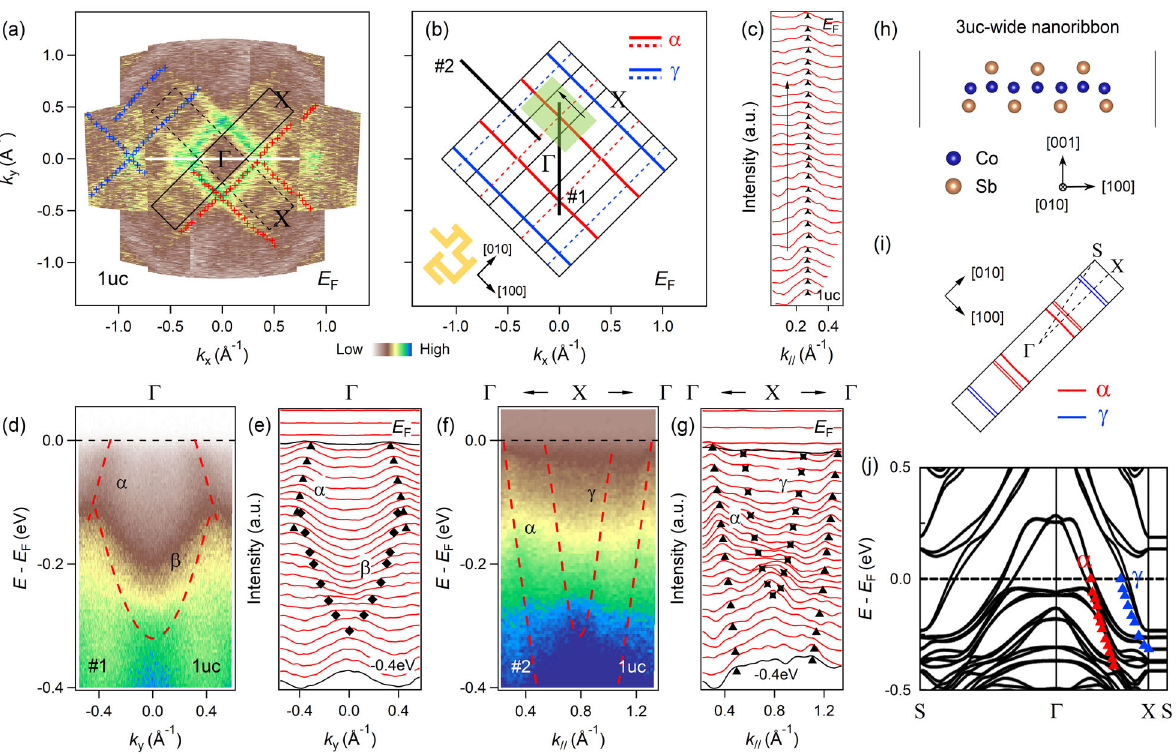
Fig. 2 FS topology and band structures of CoSb 1 − x nanoribbons. a Constant-energy ARPES image of Sample III (1 uc) was obtained by integrating the photoemission intensity within E F ± 40 meV. The red and blue cross marks are measured Fermi crossings. b Schematic FS topology of ( a ). Inset: Sketches of the [100] and [010] oriented CoSb 1 − x nanoribbons. The black solid and dashed lines in ( a ) represent the Q1D BZs of [010] and [100] oriented nanoribbons, respectively. The black solid lines in (b) indicate a series of Q1D BZs of [010] oriented nanoribbons, while the BZs of [100] orientation are omitted for better visualization. The solid and dashed schematic FS lines in ( b ) represent that of [010] and [100] oriented nanoribbons, respectively. c MDC plot of the constant-energy spectra in ( a ), which is indicated by the translucent green area in ( b ). The triangle markers are extracted from peak positions. d , e Intensity plot and corresponding MDCs along cut#1 in ( b ), respectively. f , g Same as ( d , e ) along cut#2 in ( b ). The red dashed curves in ( d , f ) are guides to the eye for the experimental band dispersions. The black markers in ( e , g ) are extracted peak positions. h Supercell contains an [010]-oriented ribbon of the freestanding tetragonal CoSb with a width of 3 uc (~1.2 nm). i Calculated FSs of the CoSb supercell in ( h ). The BZ of the supercell represented by the black solid lines shows an aspect ratio of 5: 1. j Calculated band structures of 3-uc-wide CoSb nanoribbon. The red and blue markers are experimental α and γ bands extracted from the MDCs in ( g ),